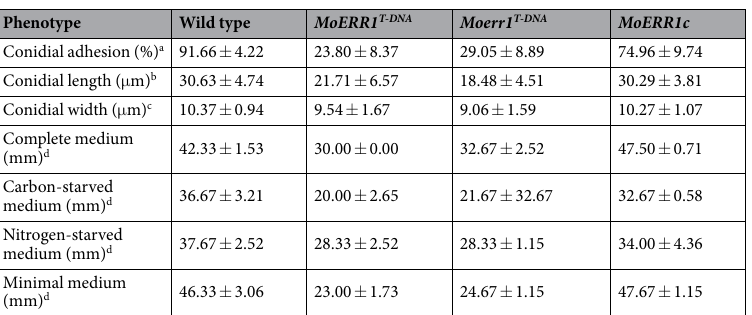
Phenotype Wild type MoERR1 T-DNA Moerr1 T-DNA MoERR1c Conidial adhesion (%) a 91.66 ± 4.22